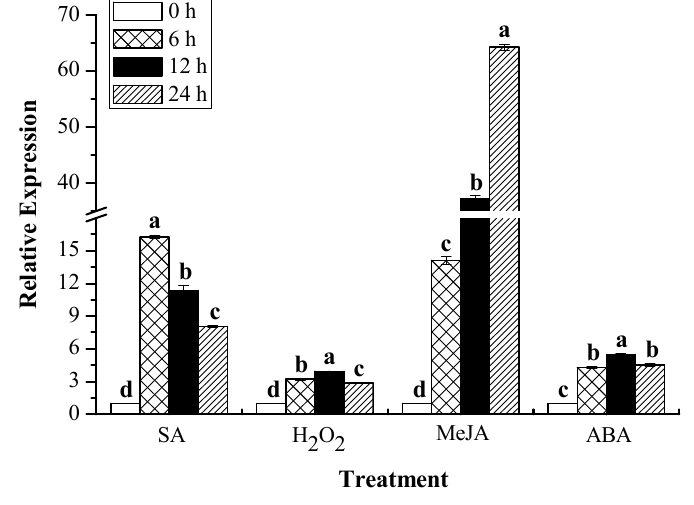
Figure 10. RT-qPCR analysis of the ScChi expression patterns in Yacheng05-179 plantlets under various abiotic stresses. Data were normalized to the GAPDH expression level. ( A ) The relative expression of ScChi under the stresses of 5 mM SA, 10 mM H 25 μ M MeJA and 100 μ M ABA; ( B – E ) the relative expression of ScChi under the stresses , 25% PEG and 4 °C low temperature, respectively. of 250 mM NaCl, 100 μ M CuCl 2 All data points are the means ± SE ( n = 3). Different lowercase letters indicate a significant difference, as determined by the least-significant difference test ( p -value <